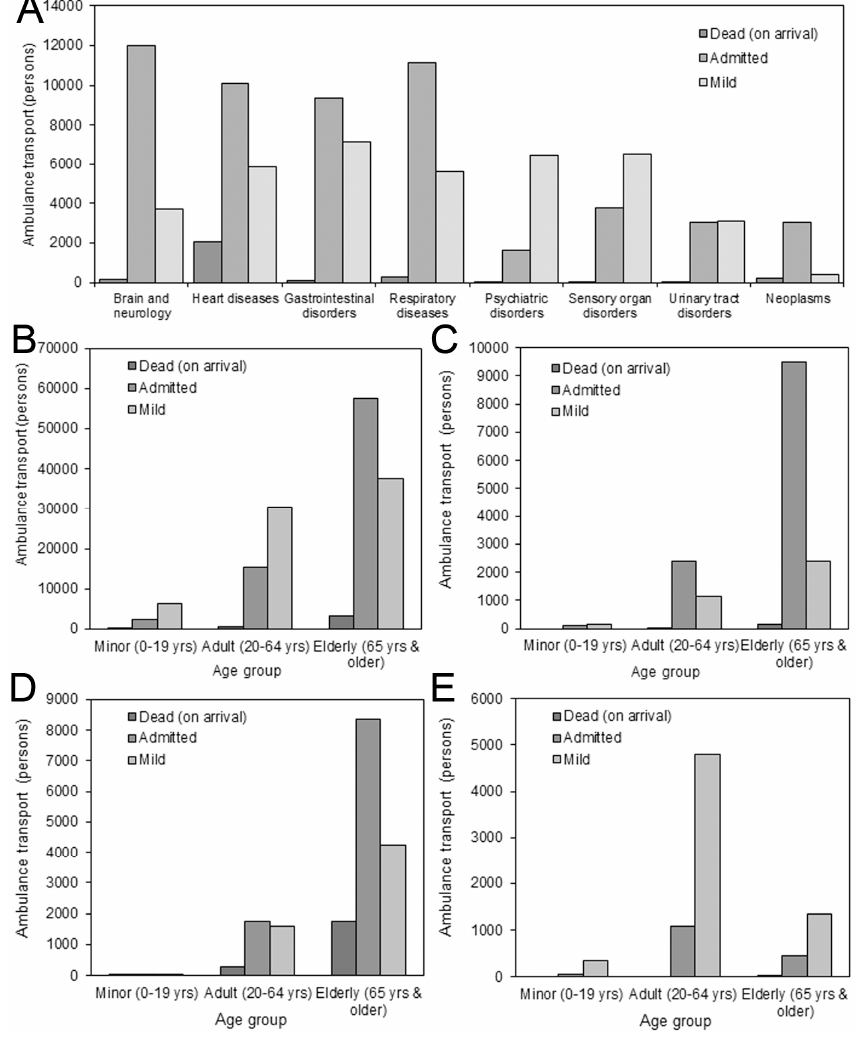
Figure 1. Severity distributions of patients transported by ambulance in 2016. All ambulance transports in Hokkaido during 2016, stratified by severity upon arrival (n=153,667). Disease-specific distributions were further stratified by age group. (A) All transports by severity and disease. (B) All transports by severity and age group. (C) Brain and neurological disorders by severity and age group. (D) Heart diseases by severity and age group. (E) Psychiatric disorders by severity and age group.